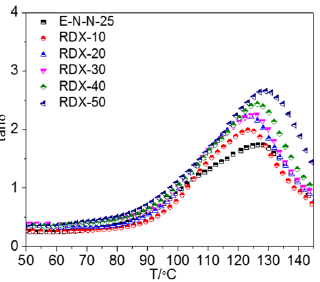
Figure 7. tan δ –T curves of model propellants with different RDX content ( γ = 1%, ω = 1 rad/s).